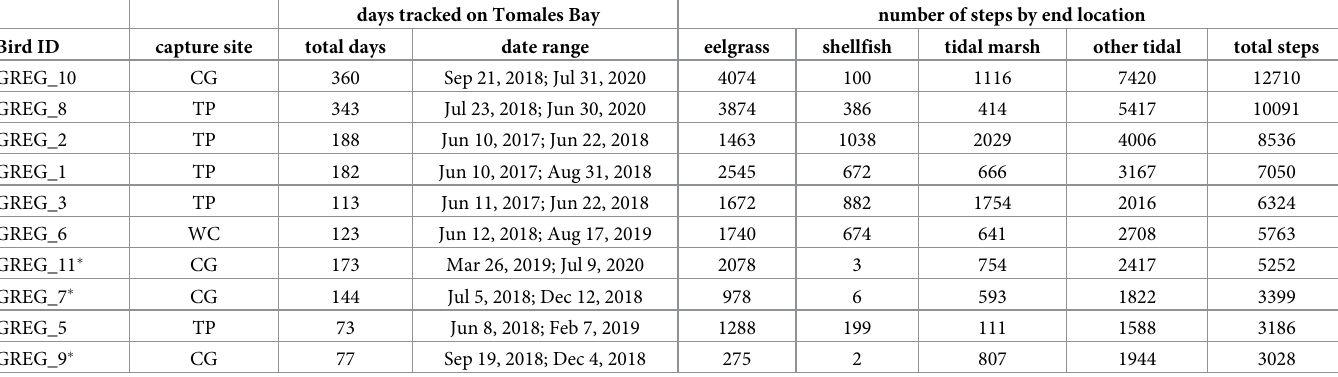
Table 1. Summary of tagged great egrets. days tracked on Tomales Bay number of steps by end